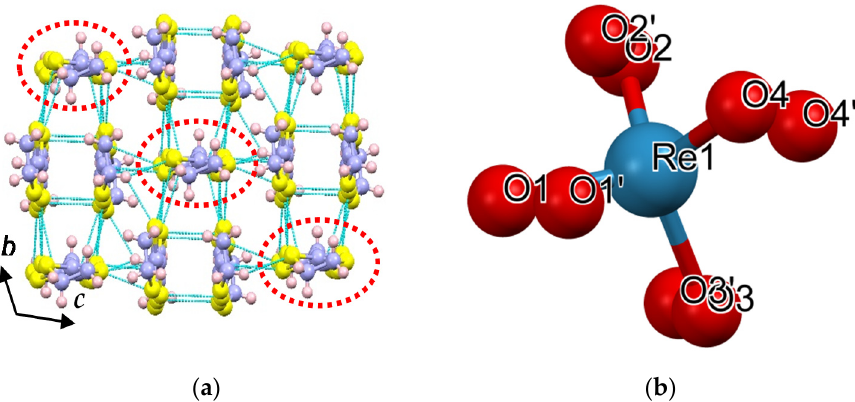
Figure 6. ( a ) Optimal view of the radical cation layers of the salt pseudo- κ″ -(BDH-TTP) 3 (ReO 4 ) 2 (3); The single molecules BDH-TTP are highlighted by circles; ( b )The disordered anion [ReO 4 ] − in the structure of 3 with the numbering of the atoms in the tetrahedron.